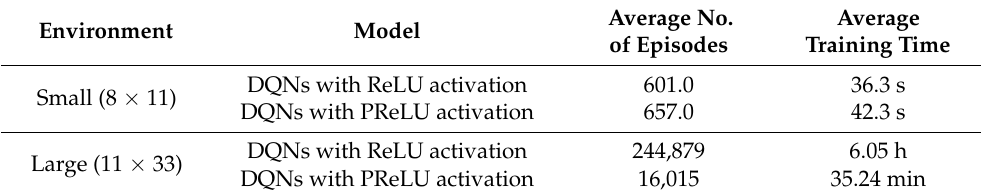
Figure 10. The comparison of Win rates when training the DQN model with two activation types in the case of the 11 × 33 grid map. ( a ) The DQN model with PReLU activation; ( b ) the DQN model with ReLU activation. Table 2. The Relative Performance of Proposed DQN